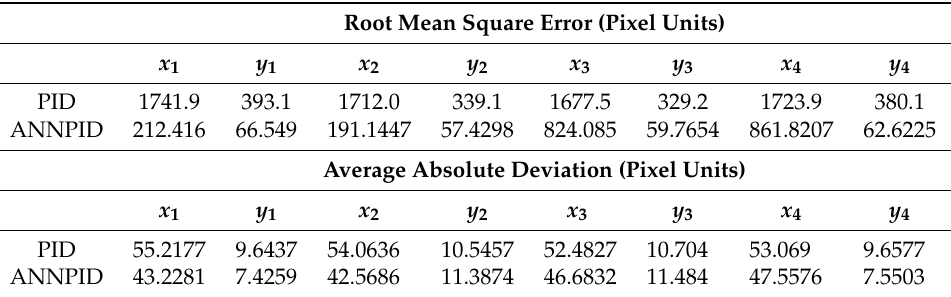
Comparison Table between conventional Proportional Integral Derivative (PID) controller and the Artificial Neural Network based PID controller